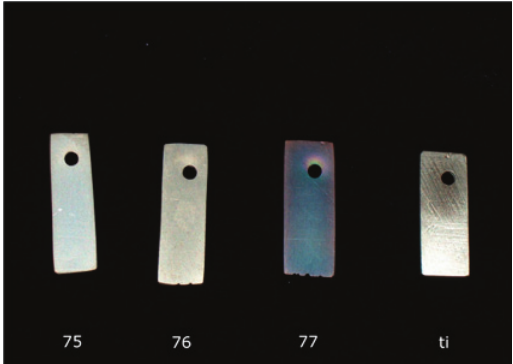
fig. 10. Samples before heat resistance tests